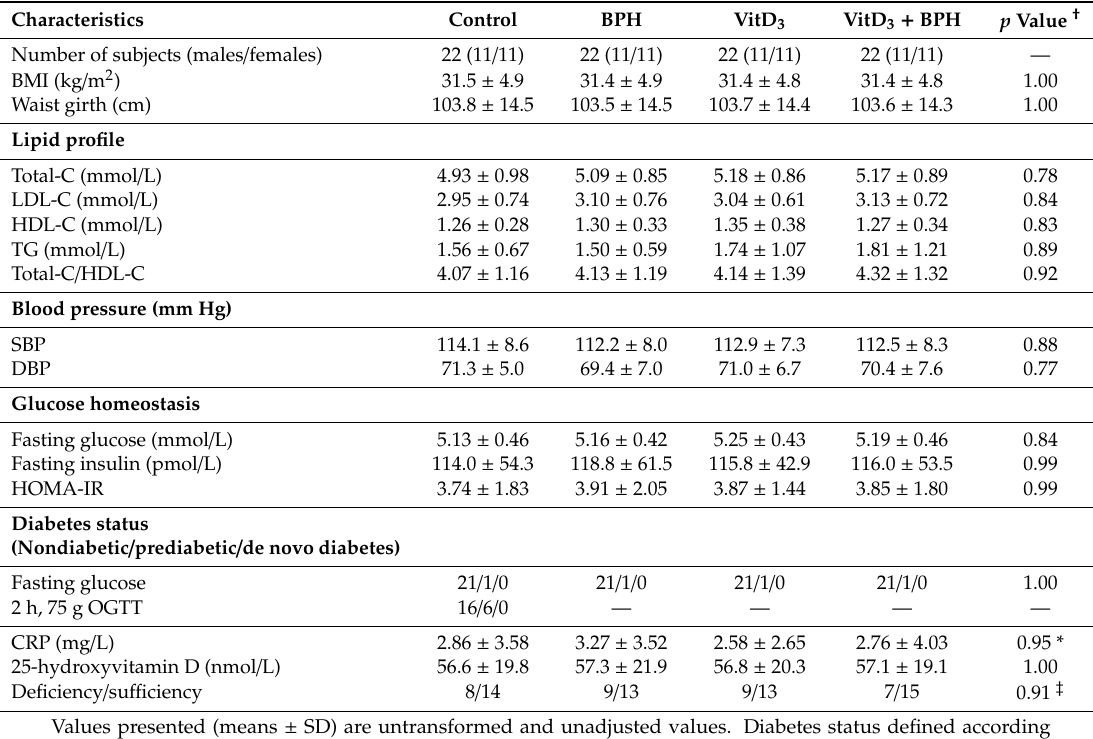
Table 1. Pre-treatment participants’